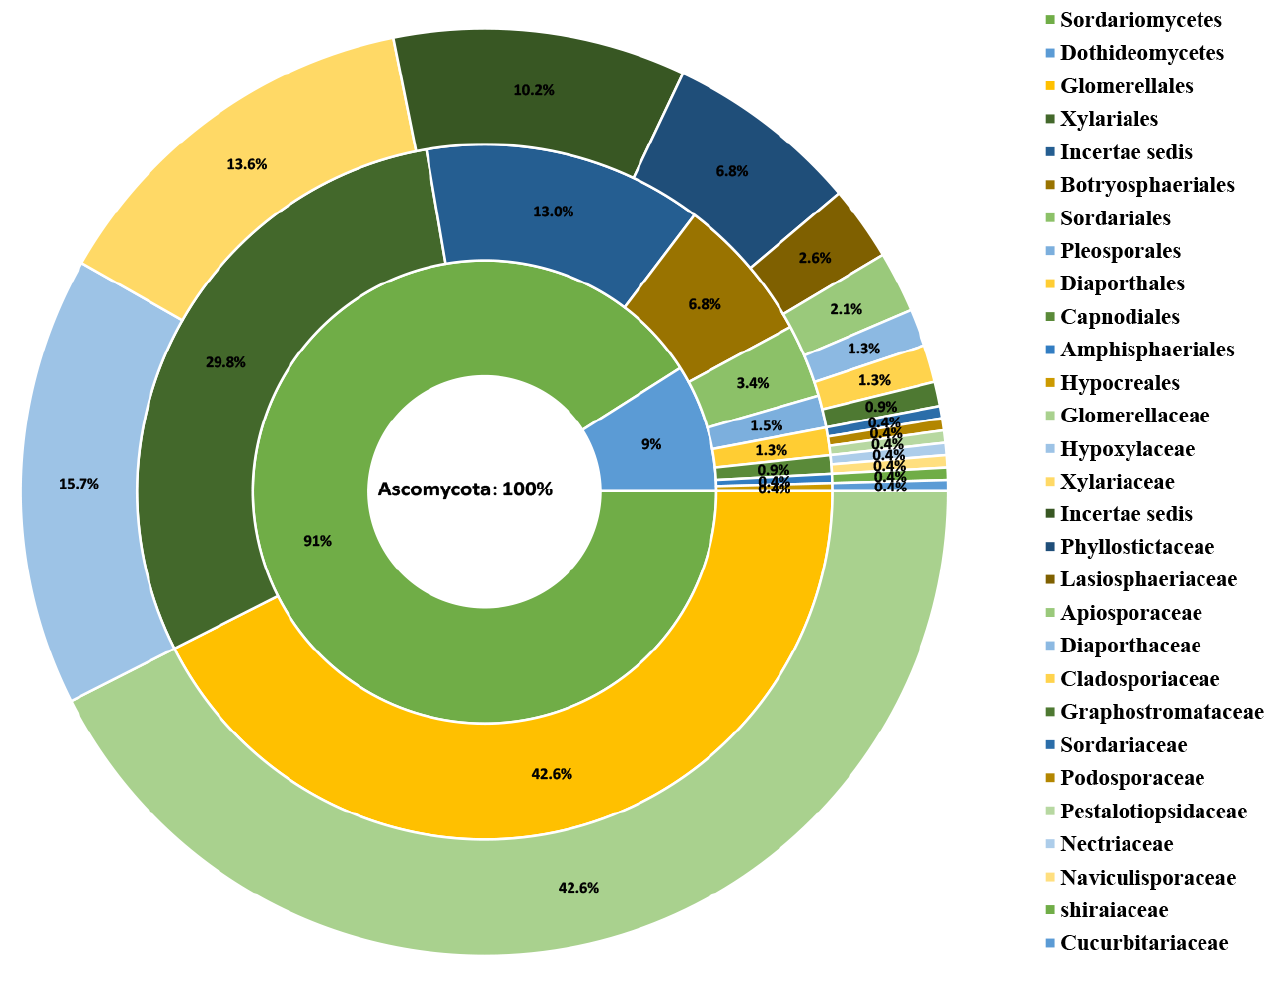
Figure 3. Taxonomic distribution of the fungal taxa ( n = 235) from the coffee.